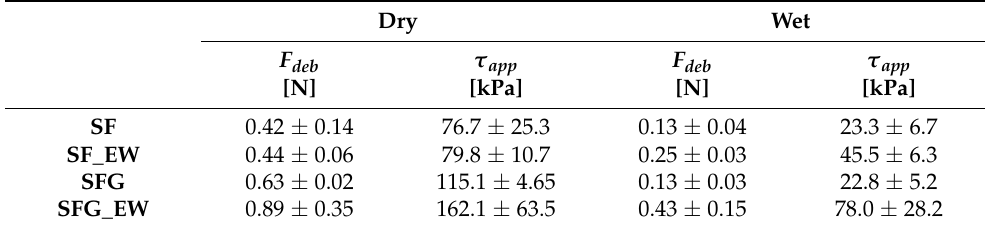
Table 3. Debonding force F deb [N] and apparent interfacial shear strength τ app [kPa] mean values along with their standard deviation for the four classes of specimens. Data were derived from the force–displacement pull-out curves for dry or wet